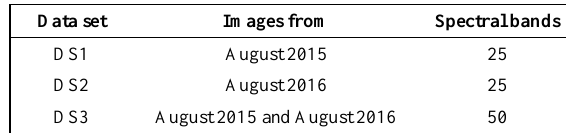
Table 3. Variables used in each data